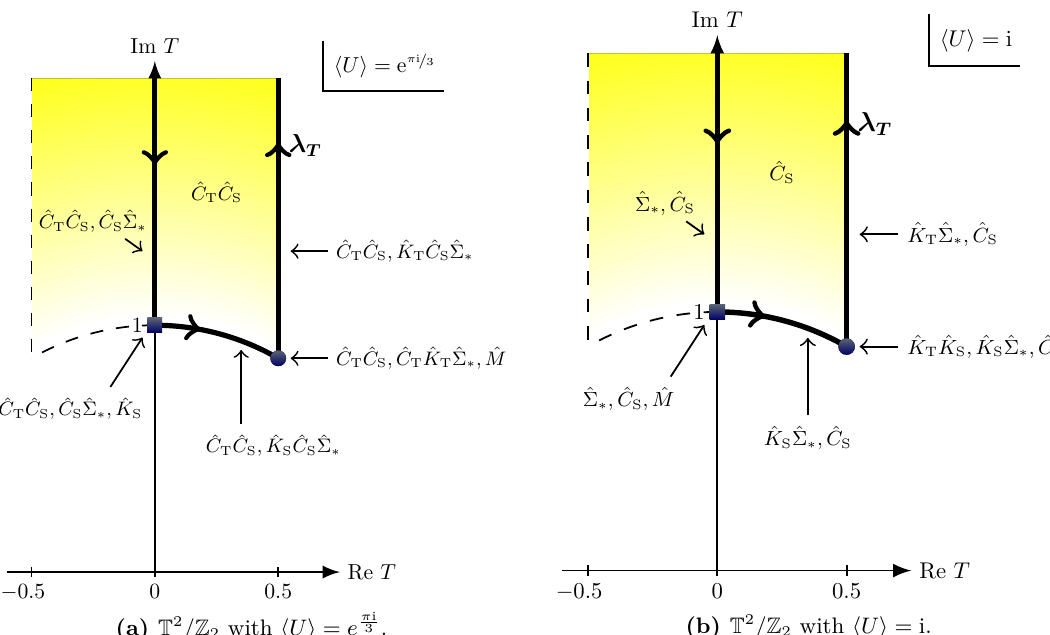
Figure 6 . Generators of the stabilizer subgroups H at different points h T i of the funda- ( h T i , h U i ) mental domain of SL(2 , Z ) T for two special vevs h U i of the complex structure modulus. These elements enhance the traditional flavor symmetry to various unified flavor